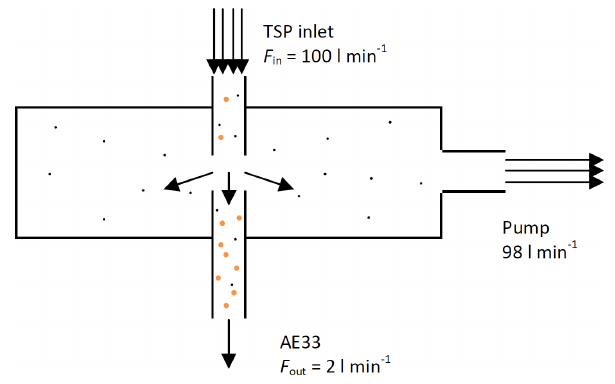
Figure 1. Operating principle of the virtual impactor (VI).